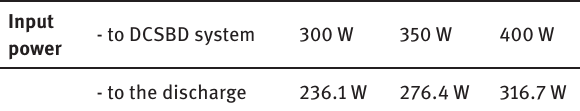
Table 1 : DCSBD input power setting and actual discharge